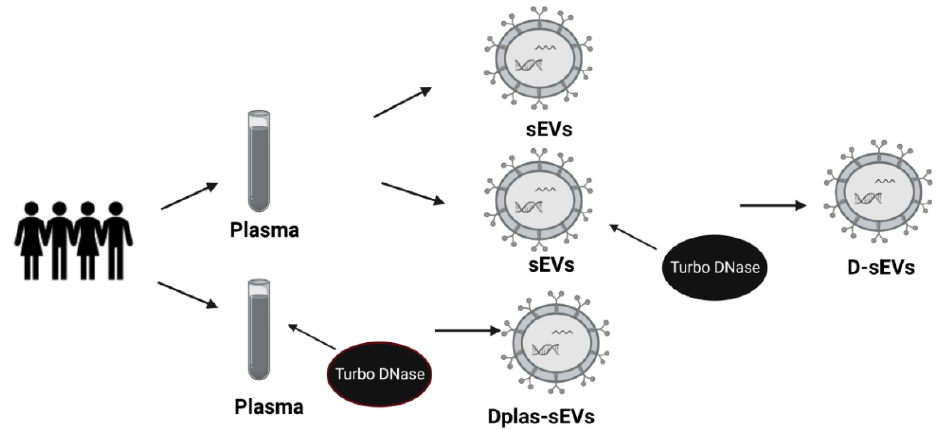
Figure 6. Scheme of sEVs isolation. Scheme of the centrifugation of human plasma and differential ultracentrifugation with iodixanol density gradient.